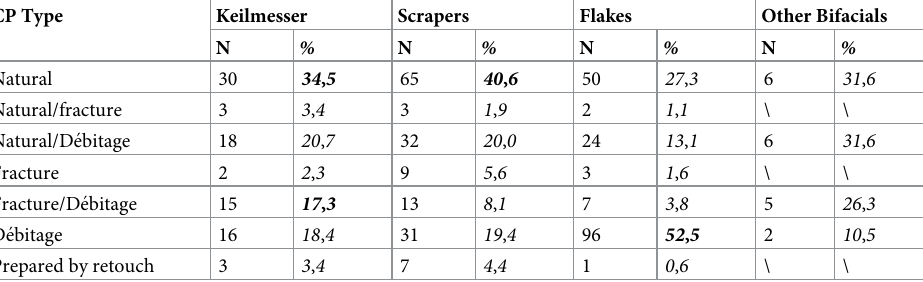
Table 7. Technological conception and nature of backs for tool techno-typological